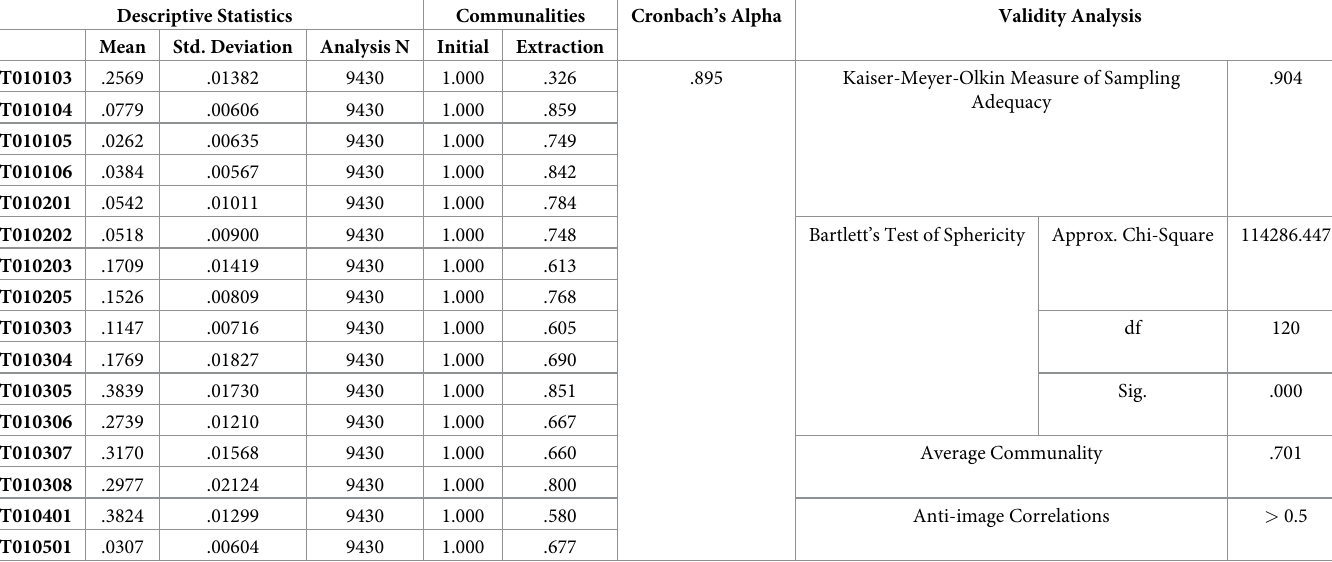
Table 7. Reliability and validity analysis of gas data in Case Study 2.